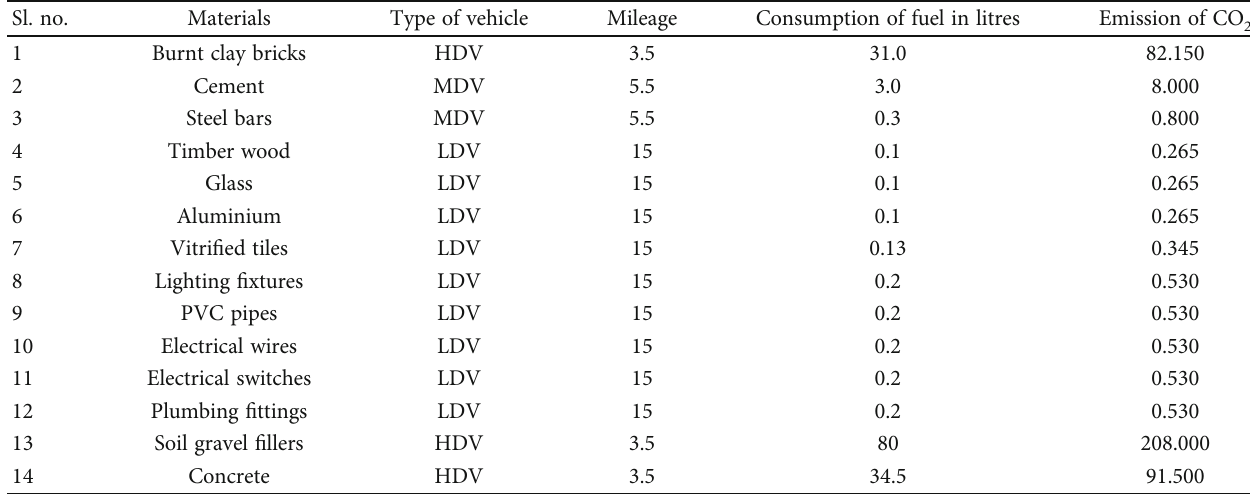
Table 5: Transportation distance and carbon emission.